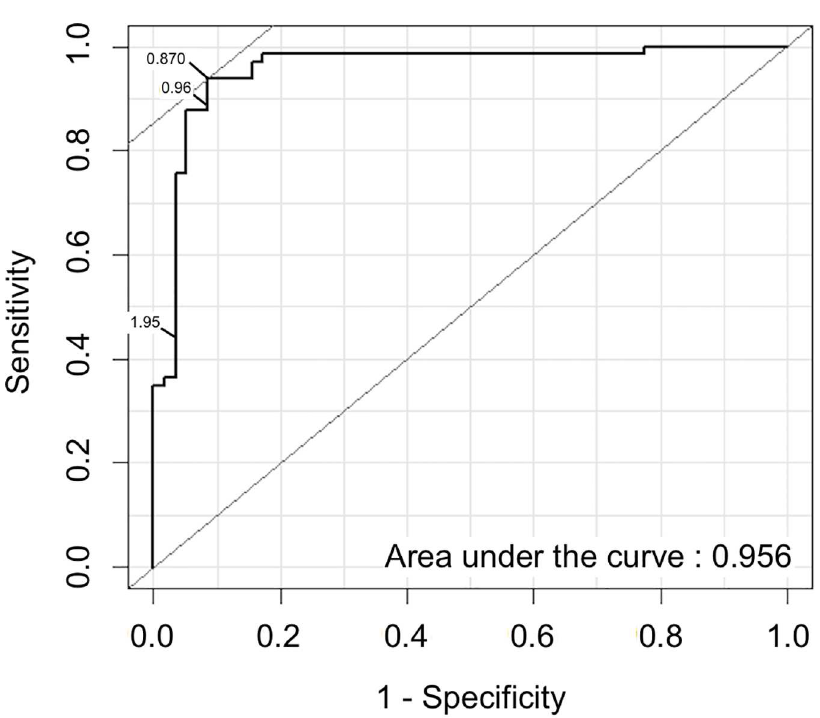
Fig 5. ReceiverOperating Characteristic (ROC) curve showing the relationship between sensitivity, specificity and threshold values. Three different thresholdswere specifiedto meet the requirements of: (A) an assay (threshold = 0.870 OD 450, specificity = 93.9%, sensitivity = 91.4%, PPV = 89.8%, NPV = 92.4%) with balanced sensitivity and specificity (maximal Youden’sJ value); (B) an assay (threshold= 0.965 OD 450, specificity 94.8%, sensitivity = 89.4%) with at least 80% sensitivity and (C) an assay (threshold= 1.951 OD 450 , specificity = 98.3%, sensitivity = 43.9%, PPV = 66.7%, NPV = 95.0%) with at least 98%